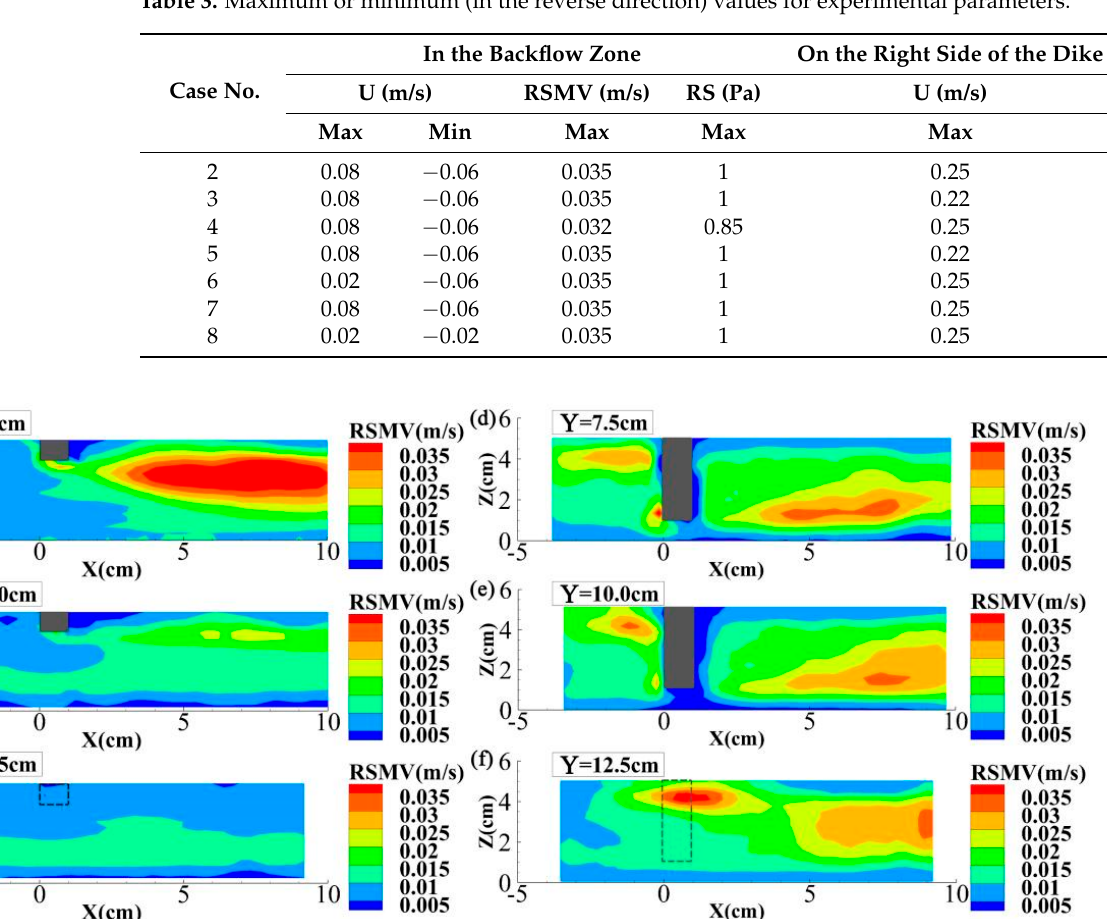
Figure 9. Distributions of vertical turbulent intensity at longitudinal sections ( a ) Y = 7.5 cm, ( b ) Y = 10.0 cm, ( c ) Y = 12.5 cm in Case 3 (on the left) and at longitudinal sections ( d ) Y = 7.5 cm, ( e ) Y = 10.0 cm, ( f ) Y = 12.5 cm in Case 4 (on the right). The grey areas in subfigures ( a ), ( b ), ( d ) and ( e ) demon- strate the floating dike, and the dotted lines in subfigures ( c ) and ( f ) indicate the location of floating dike in the coordinate system.